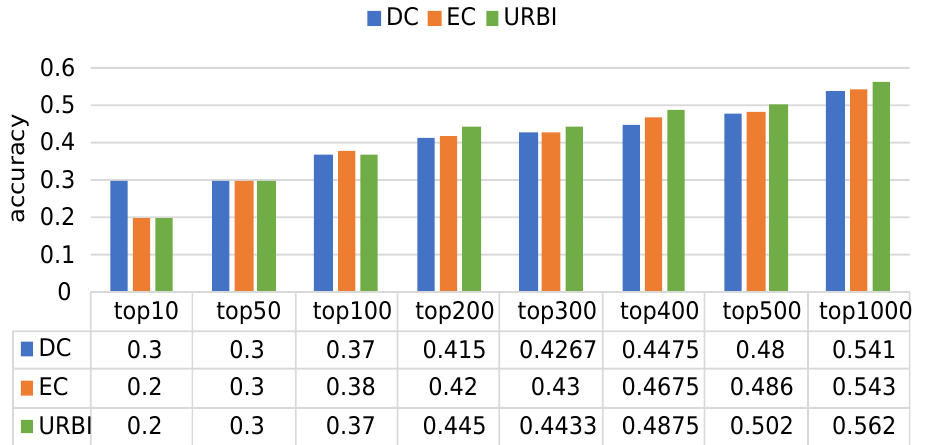
Figure 16. This figure depicts the experimental results of dataset No.16, which contains 10,724 book